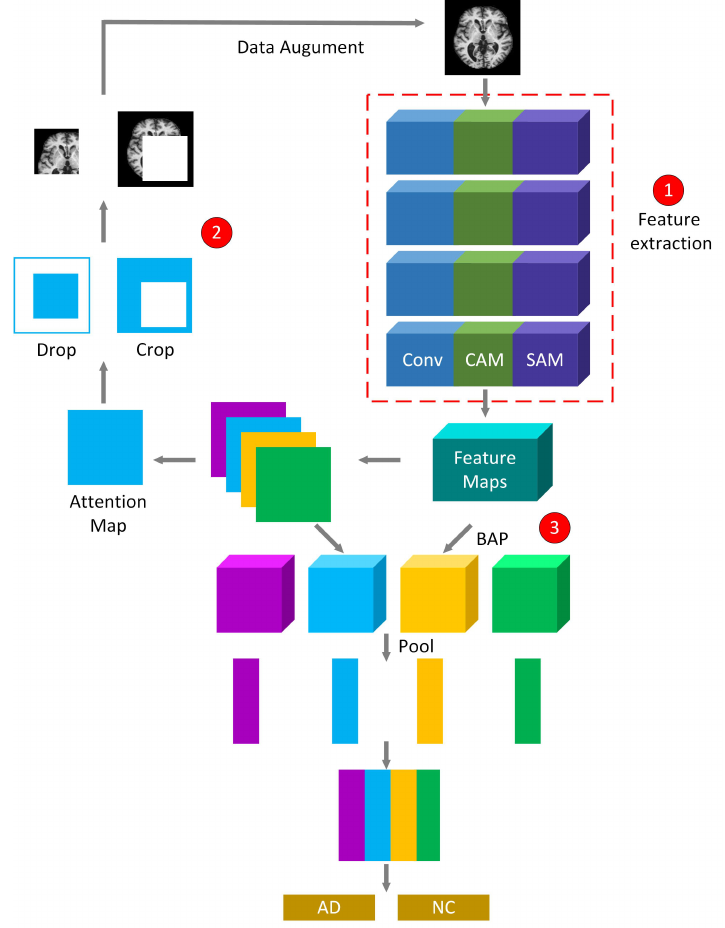
Figure 4. The training process of